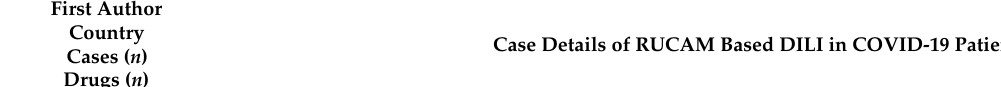
Table 2. Reports of COVID-19 patients with DILI assessed for causality using